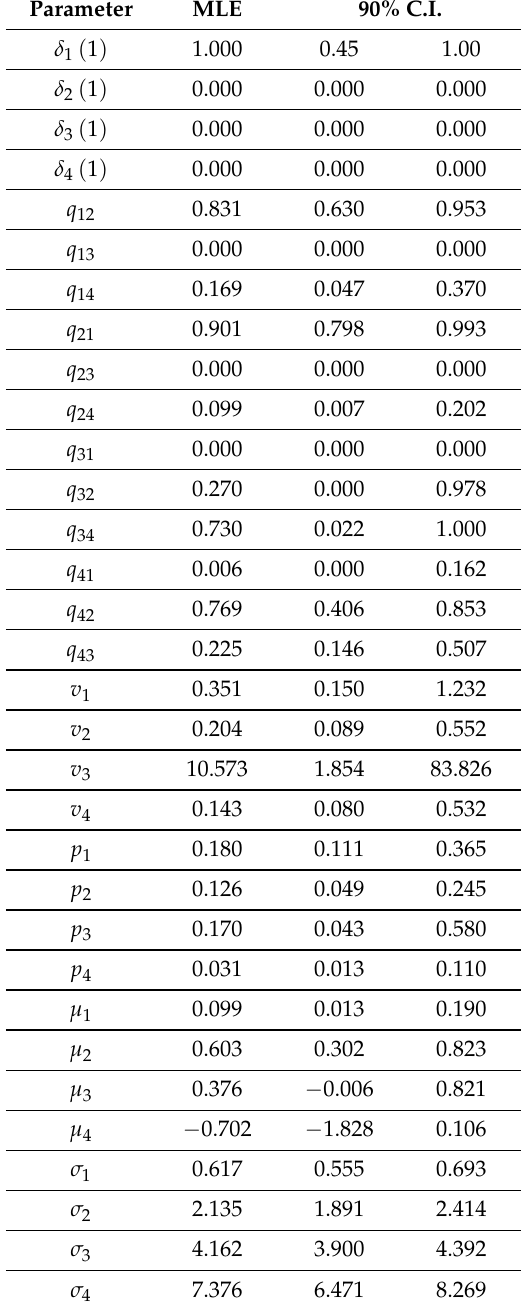
Table 3. Parameter estimates and parametric bootstrap confidence intervals for the homogeneous four-state HSMM based on the complete BTC/USD log returns